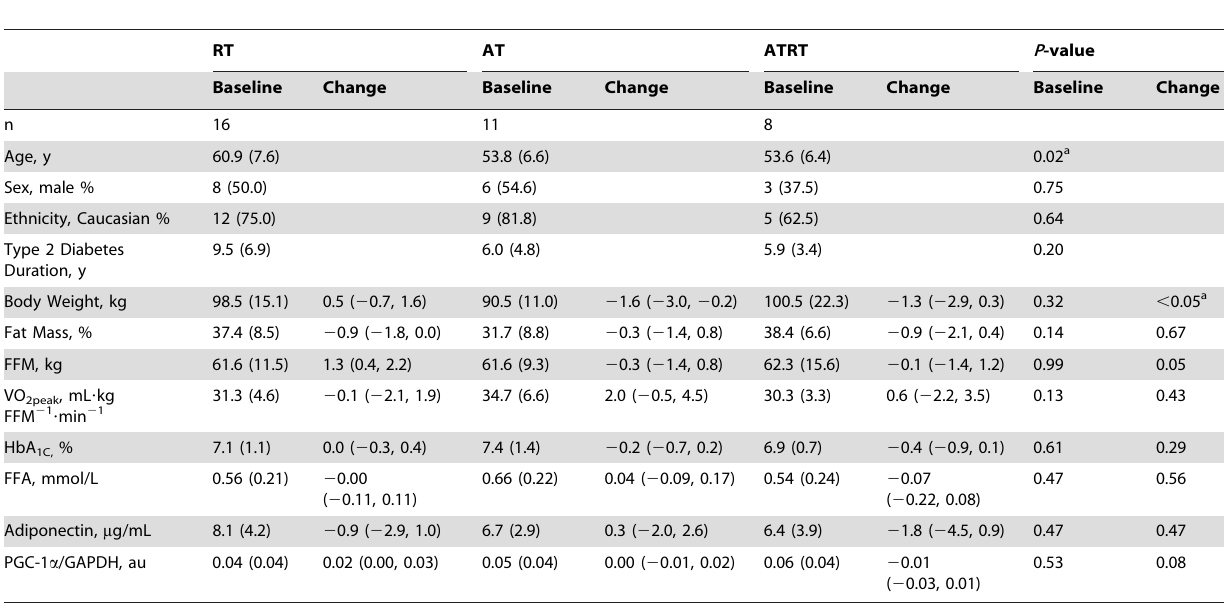
Table 1. Baseline participant characteristics and baseline adjusted changes in anthropometric data, HbA 1C , PGC-1 a protein content, and fasting adiponectin and free-fatty acids after 9 months of exercise.